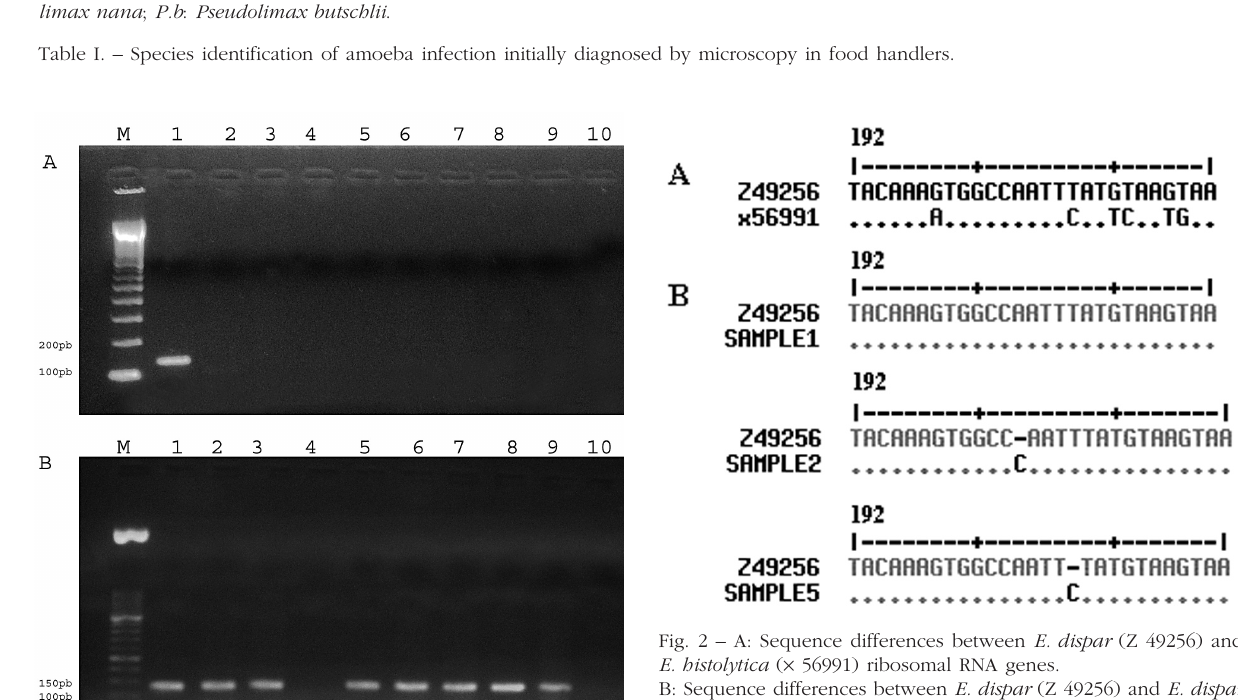
Table I. – Species identification of amoeba infection initially diagnosed by microscopy in food handlers.